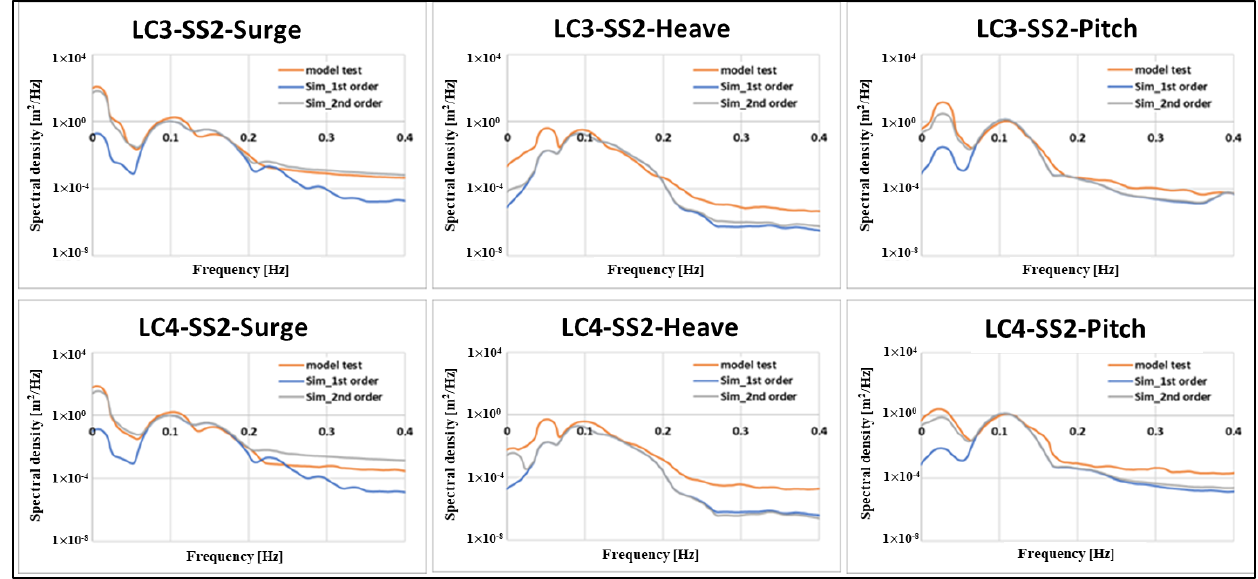
Figure 13. Sea state1: LC3 and LC4 result under irregular waves.